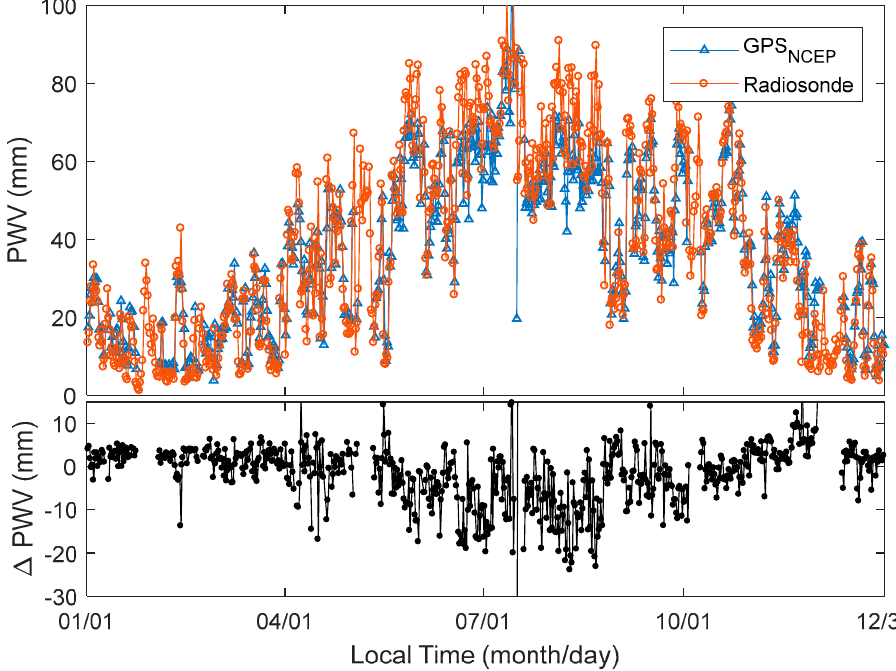
Figure A8. The PWV time series from GPS and radiosonde at GPS Keqi station and HAZH radiosonde station, respectively.